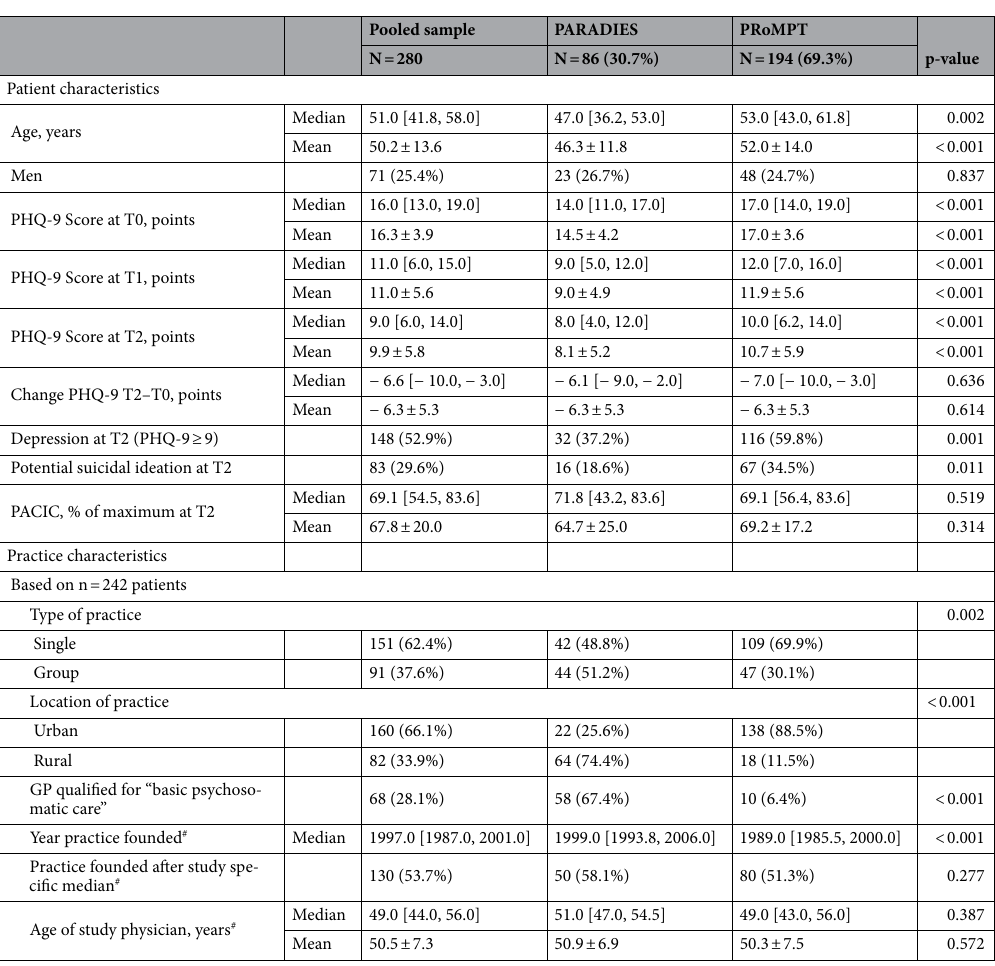
Table 1. Patients’ and GPs’/practice characteristics (intervention arms). Continuous variables are presented as median [1st quartile, 3rd quartile] with p-values from Mann-Whitney U test and mean ± standard deviation with p-values from t-test. Categorical variables are presented as counts and percentages with p-values from Χ 2 -Test. # Based on n =